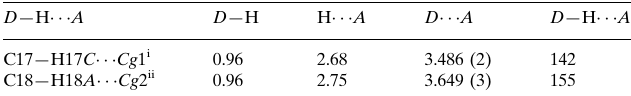
Hydrogen-bond geometry (A˚ , (cid:2)